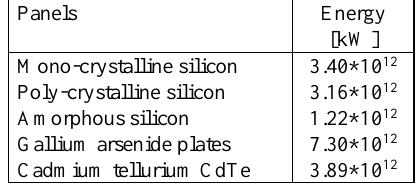
Table 2 . Solar energy